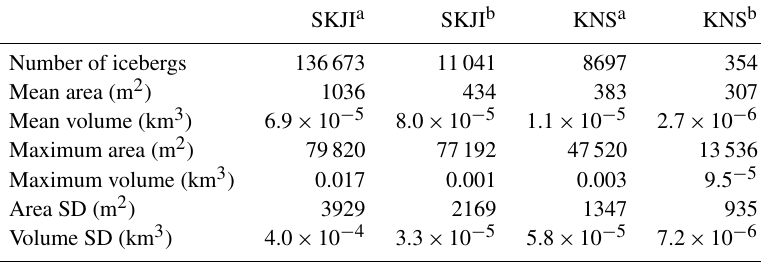
Table 2. Summary statistics of the two distributions outlined at SKI and